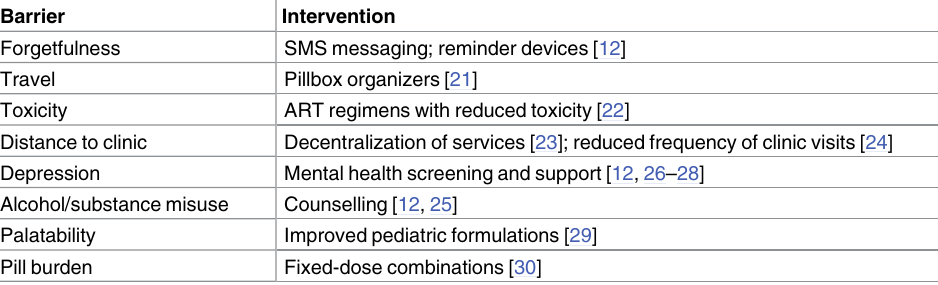
Table 2. Common barriersto adherence and corresponding interventions supported by evidence from randomized